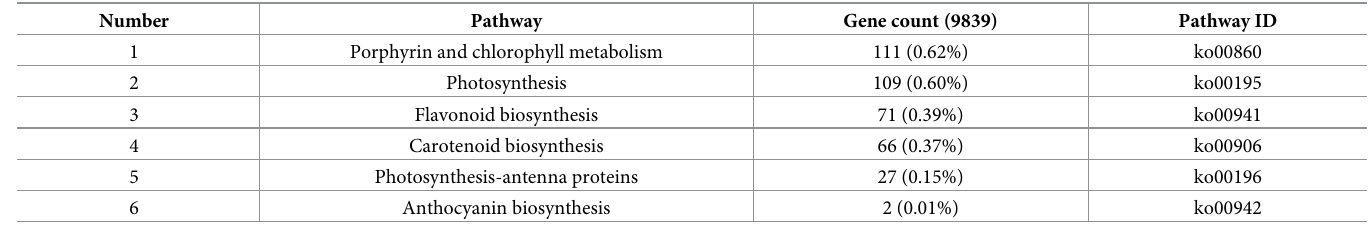
Table 3. Leaf color-related metabolic pathways in Pennisetum setaceum ‘Rubrum’.